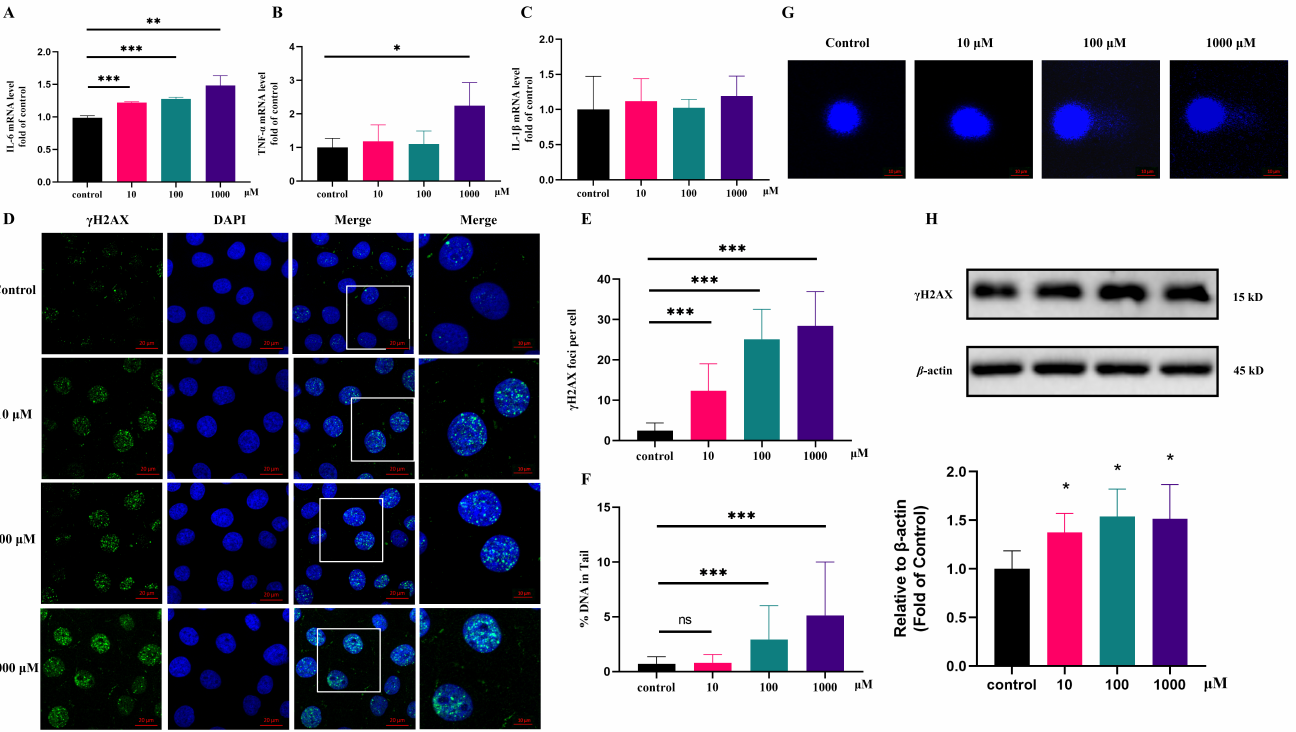
Figure 4. Pyroglutamic acid could promote inflammation and increase DNA damage in IEC-6 cells. ( A ) The mRNA levels of IL-6 detected by QPCR. ( B ) The mRNA levels of TNF- α detected by QPCR. ( C ) The mRNA levels of IL-1 β detected by QPCR. ( D ) Representative images of γ H2AX immunofluorescence staining. Image sizes are annotated by the scale bar in the lower right corner of the respective image. ( E ) Immunofluorescence histograms showing γ H2AX foci per cell. ( F , G ) Comet assay and histograms showing %DNA in the tail. ( H ) Western blot of γ H2AX. Data are presented as the means ± SEM. * p < 0.05, ** p < 0.01, *** p < 0.001, ns not significant vs. control